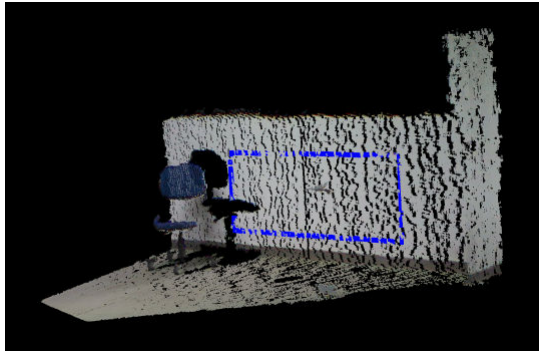
Figure 2. RANSAC and Narrow Down Filter result.